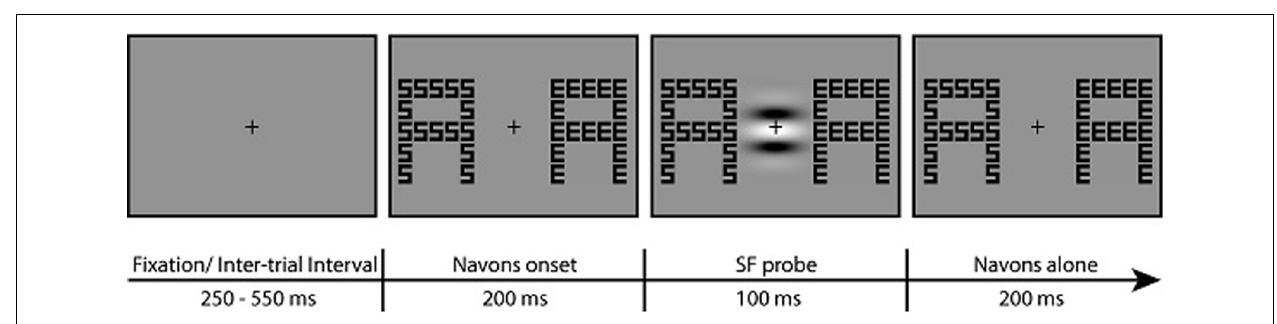
FIGURE 1 | (A) Plots showing the spatial frequency (SF) spectrum of the Navon displays and the global versus local letters. Power is shown for SFs in cycles/image. The SFs used in the experiment – 0.7 cycles/degree (cpd) and 3 cpd – are highlighted. The left plot shows the SF spectrum for Navon displays used in the experiment. The middle plot shows the SF